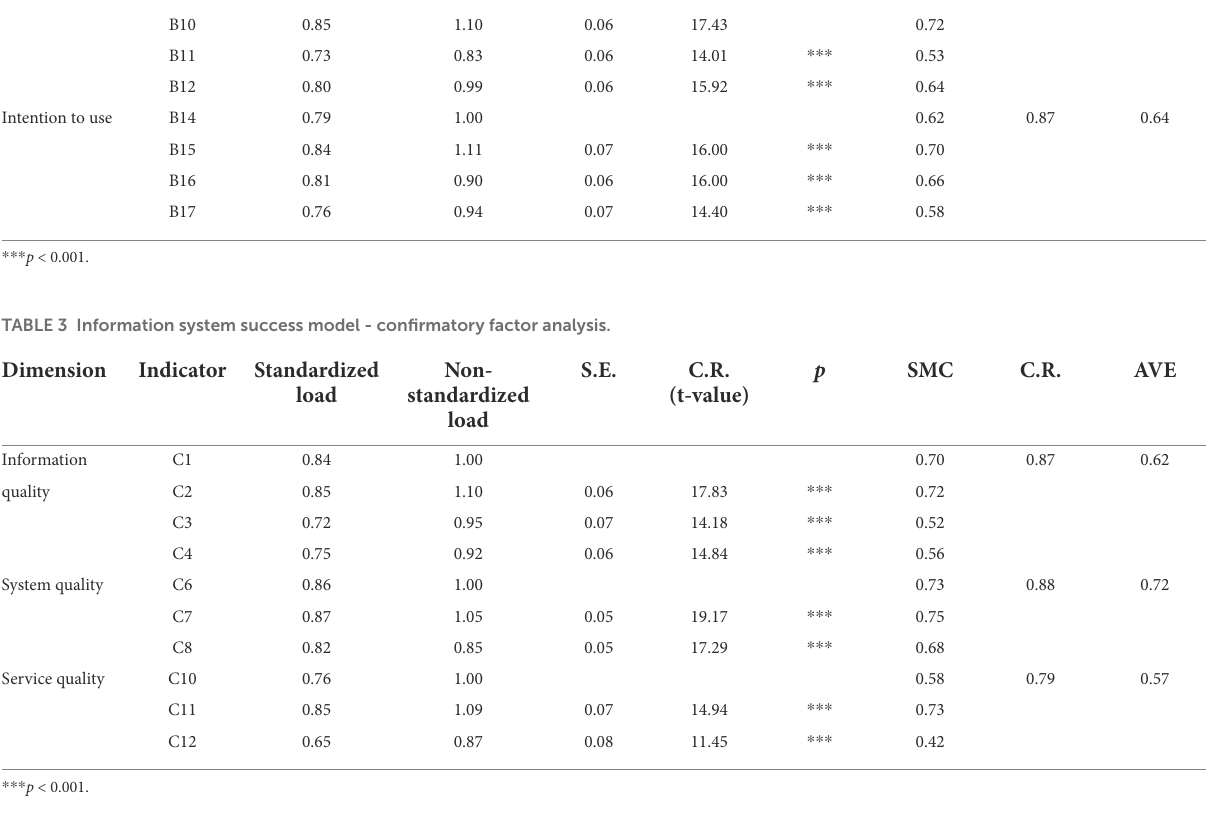
TABLE 4 Diffusion of innovations theory - confirmatory factor